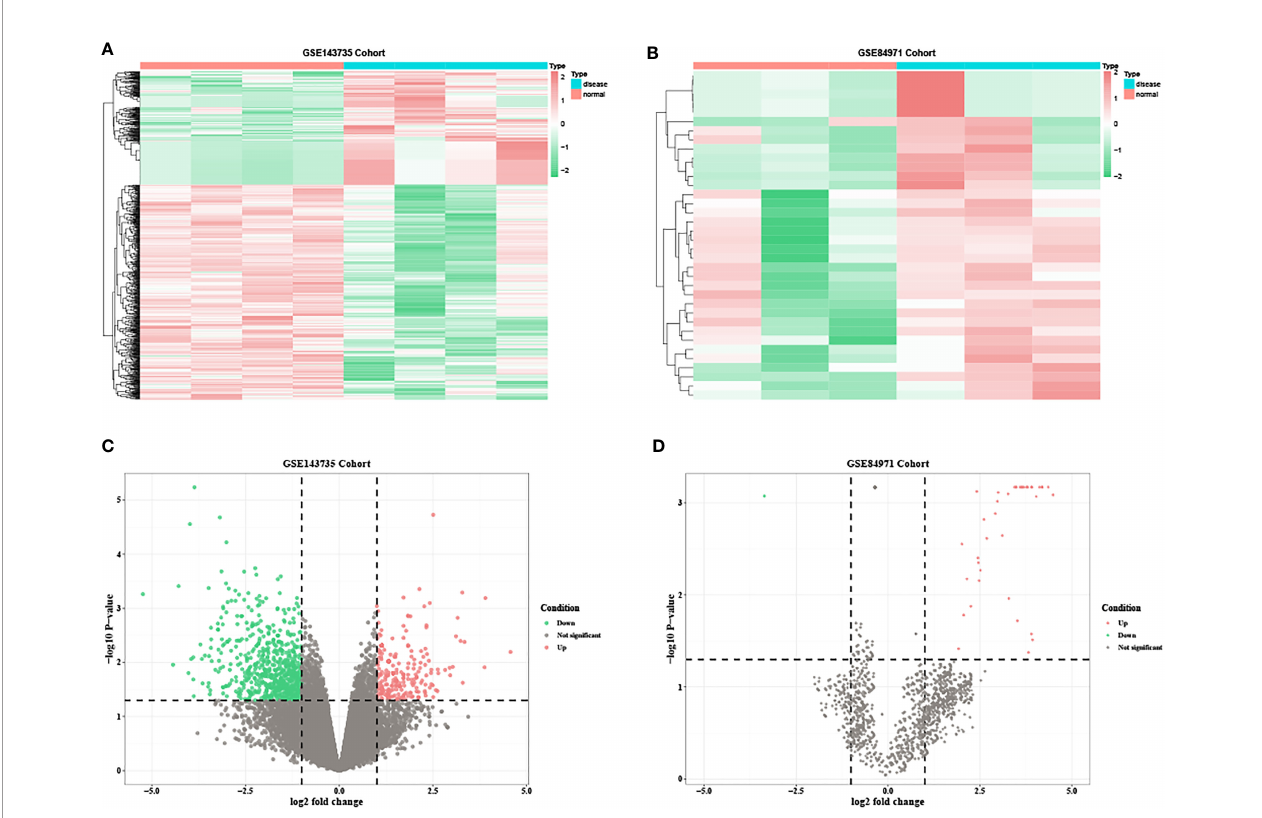
FIGURE 3 | The heatmap and volcano plots of DEmRNAs in GSE143735 and DEmiRNAs in GSE84971. (A) Heatmap of DEmRNAs in GSE143735. (B) Heatmap of DEmiRNAs in GSE84971. (C) Volcano plot of DEmRNAs in GSE143735. (D) Volcano plot of DEmiRNAs in